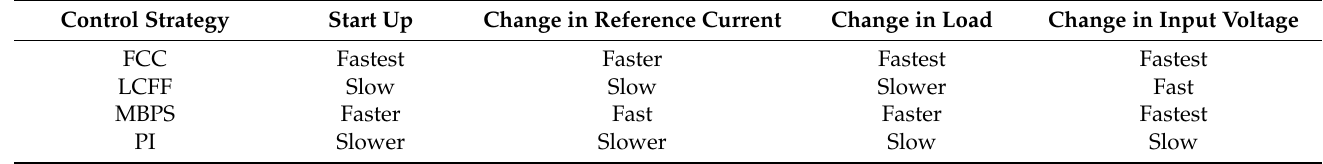
Table 5. Comparison of controllers in terms of robustness and effectiveness under various